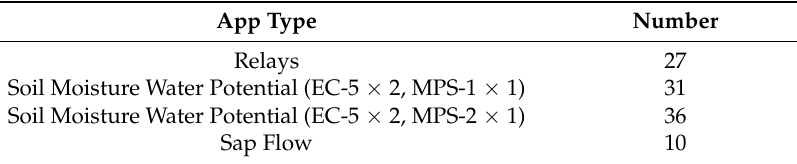
Table 5. Distribution of nodes by type of